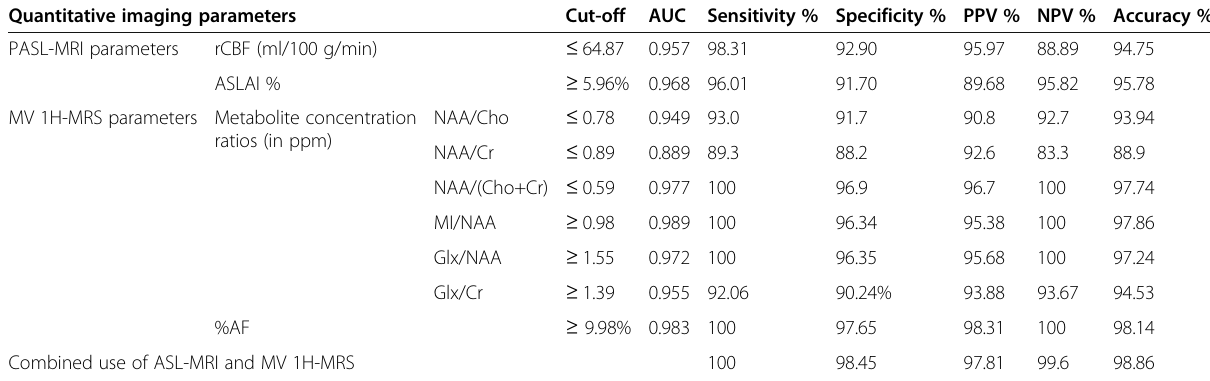
Table 7 Cut-off values with sensitivity, specificity, predictive values and accuracy of PASL-MRI and 1H-MRS in identification of epileptogenic zone in patients with FIAE (n= 26) Quantitative imaging